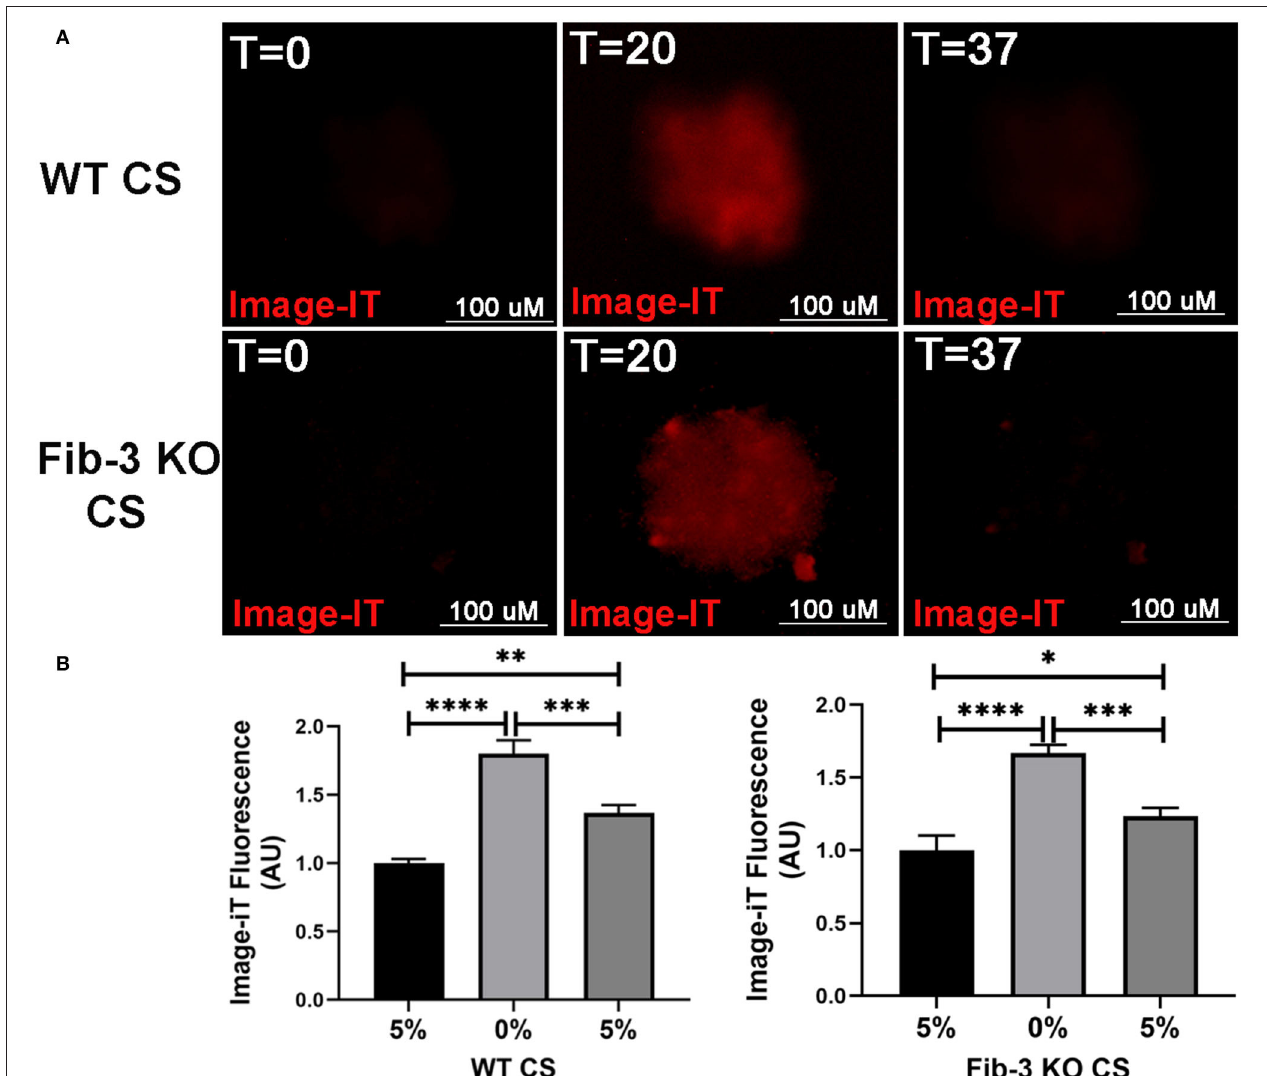
FIGURE 3 | Establishment of hypoxic/normoxic damage in Fib-3 KO and WT CSs. (A) Epifluorescent images of a representative CS treated with Image-iT (become fluorescent red in lower oxygen conditions) that was pre-incubated at 5% O 2 for 24h (T = 0), and then exposed to 0% O 2 for 20h (T = 20) and 5% O 2 for additional 17h (T = 37). (B) Statistical analysis of changes i n Image-iT fluorescence between 5% (T = 0), 0% (T = 20) and 5% (T = 37) between WT and Fib-3 KO CSs. One-way ANOVA with Tukey post-hoc test was used f or comparison of all groups, p < 0.05 = *, p < 0.01 = **, p < 0.001 = ***, and p > 0.0001 = ****. Error bars represent the mean ± SD ( n =